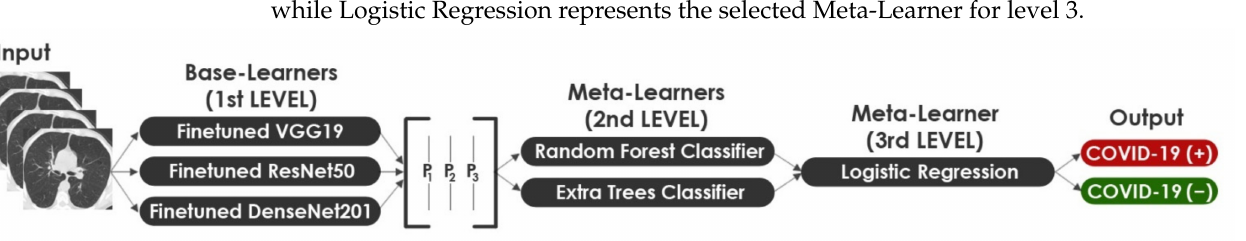
Figure 15. Representation of the 3-Levels Stacking approach.